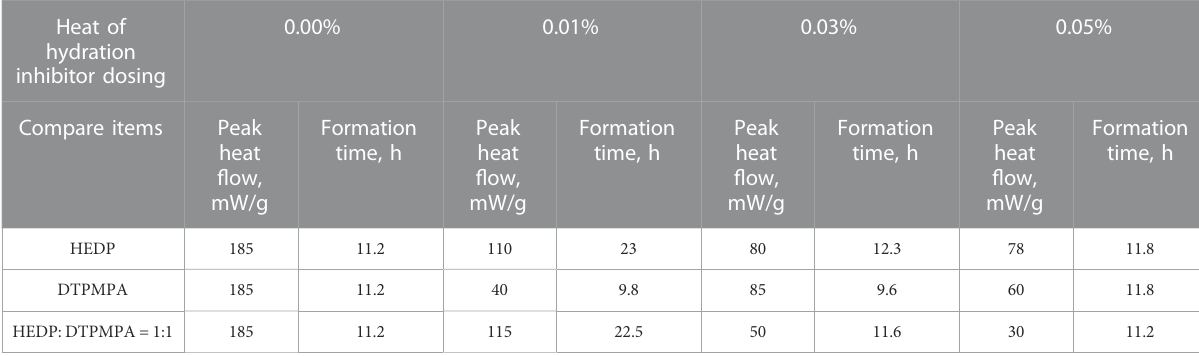
TABLE 5 Heat release rate data of the C 3 S hydration reaction.